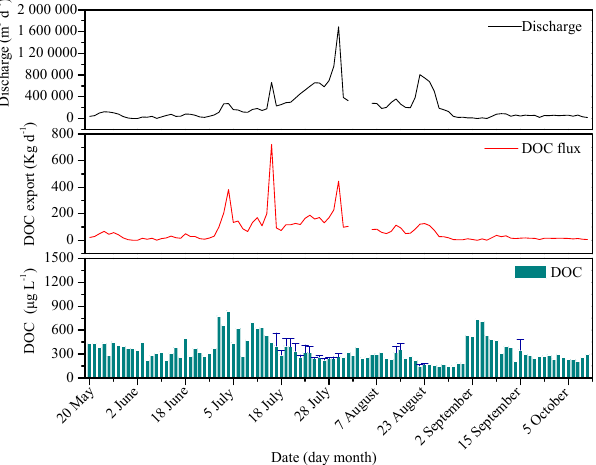
Figure 7. The discharge, DOC concentrations and fluxes exported from LHG in 2015. The concentrations with error bars are used for days with more than one